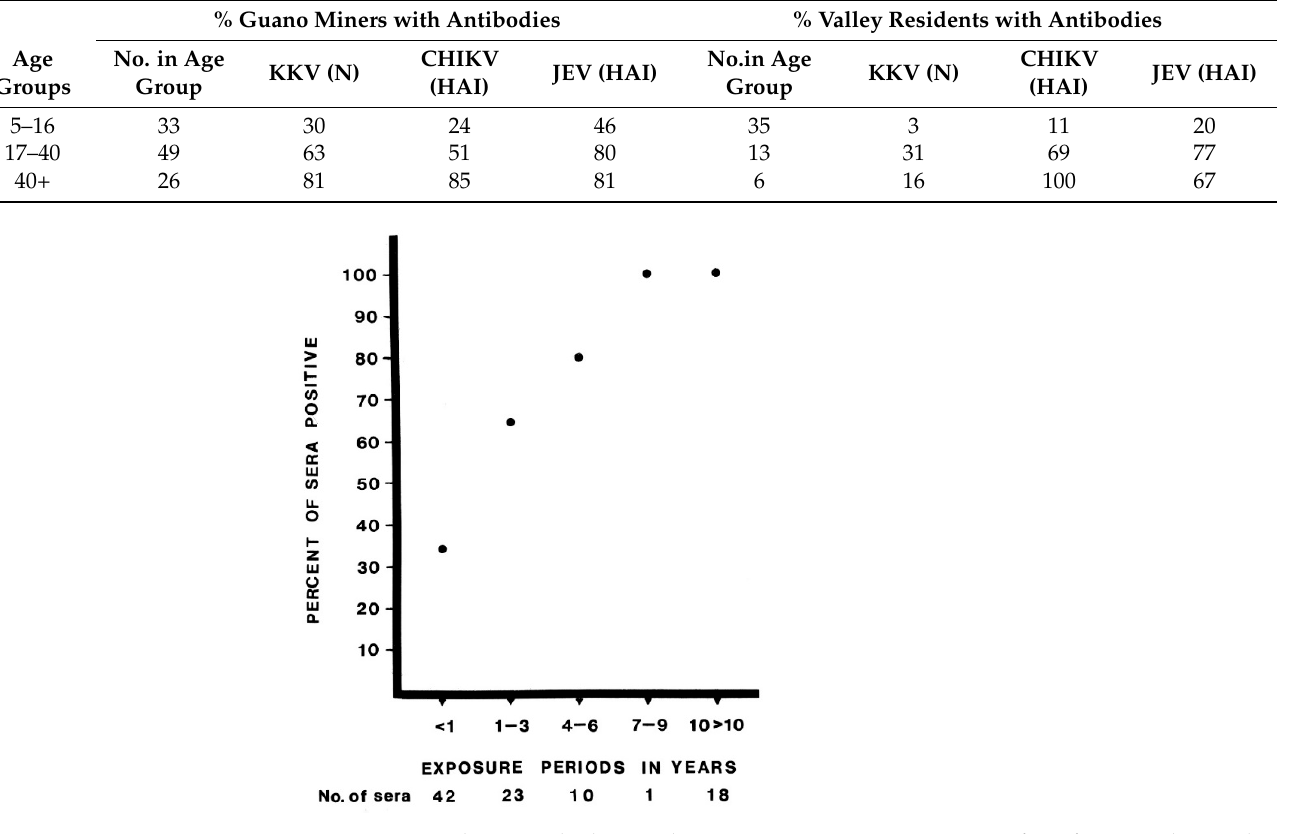
Figure 4. Neutralizing antibody prevalence against KKV in guano miners from five caves by number of years the individuals reported to work as guano miners.